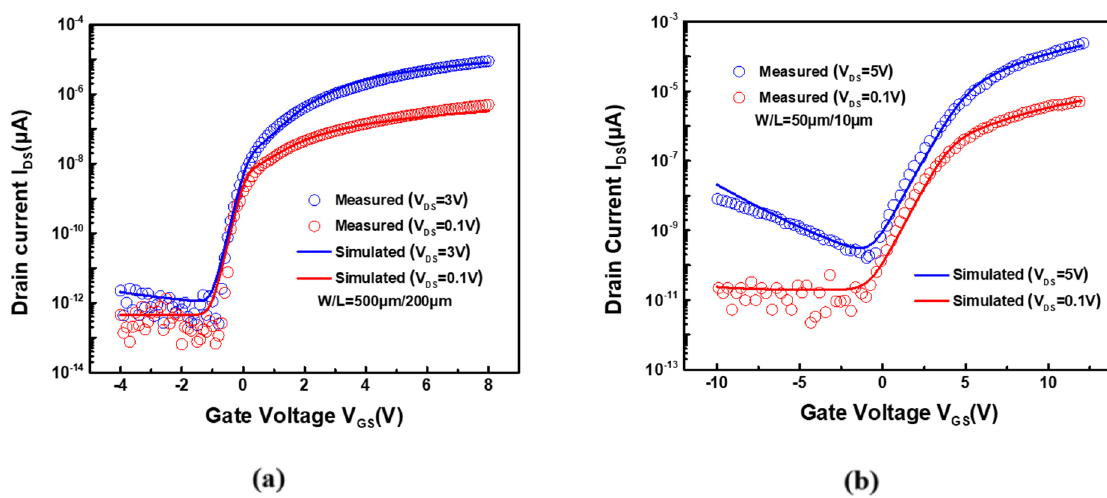
Figure 3. Simulated and measured transfer characteristics of the ( a ) a-IZTO TFT; ( b ) LTPS TFT.